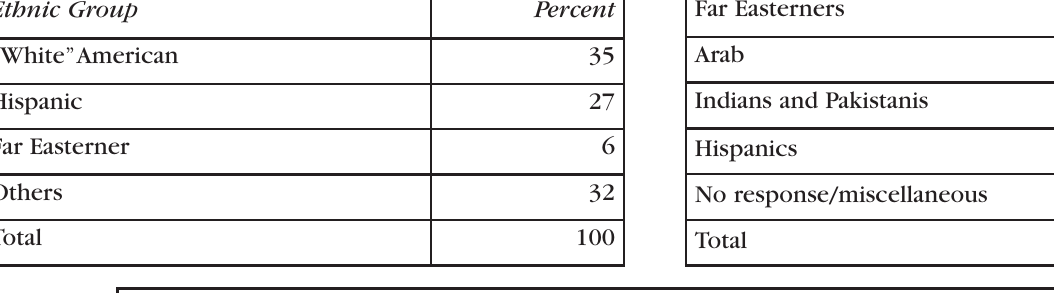
Table 10. Type and Source of Business